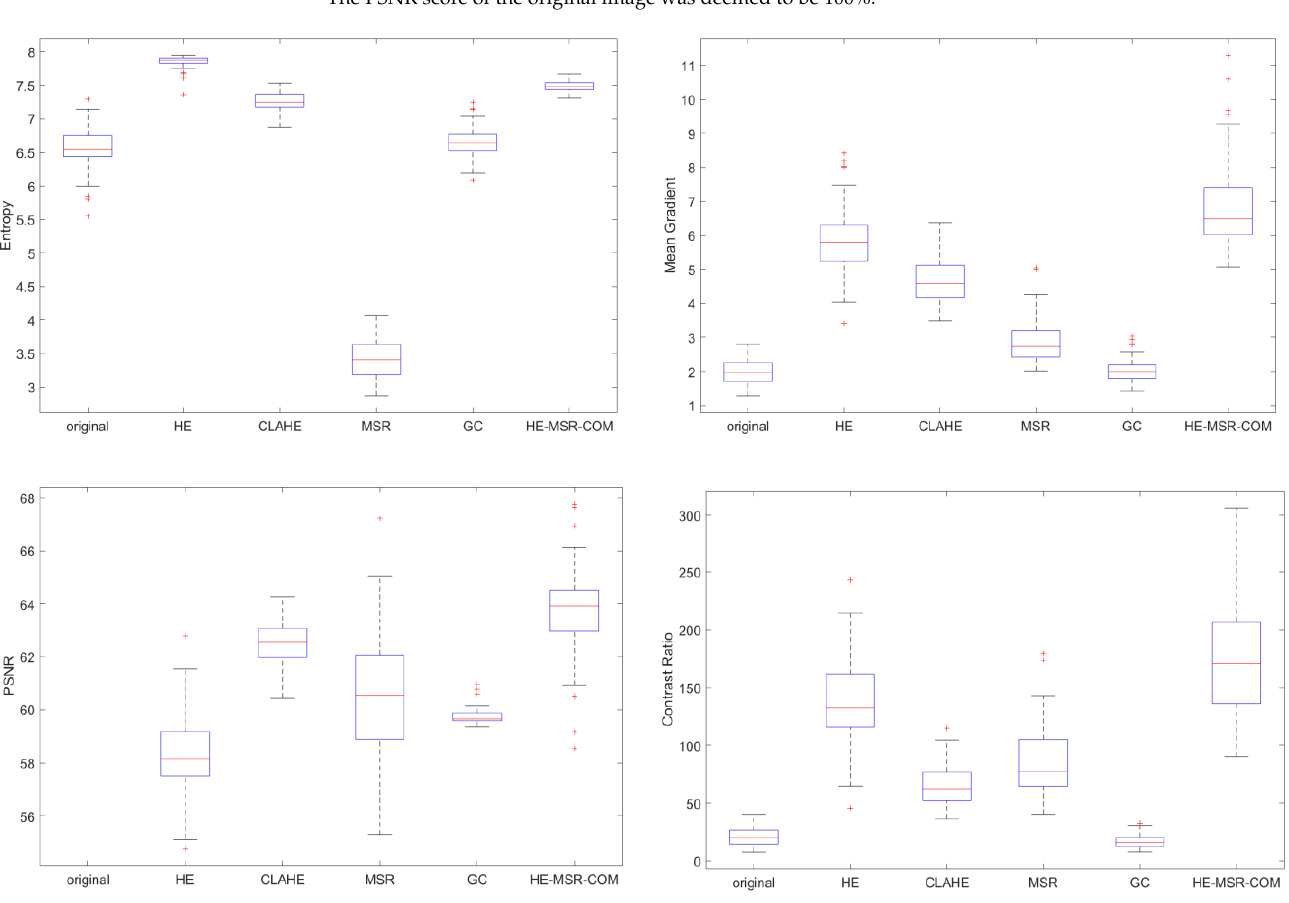
Figure 9. Evaluation distribution in Cityscapes.